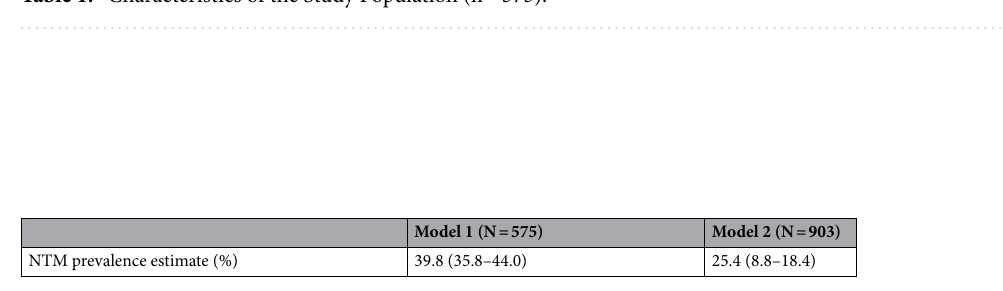
Table 2. Estimated prevalence of NTM in study population. Model 1 used samples from 575 participants found to have complete data on MGIT cultures after re-growing stored, decontaminated sputum samples. Model 2 used the original number of 903 participants found in the parent study with the assumption that the negative results for 328 participants, are truly